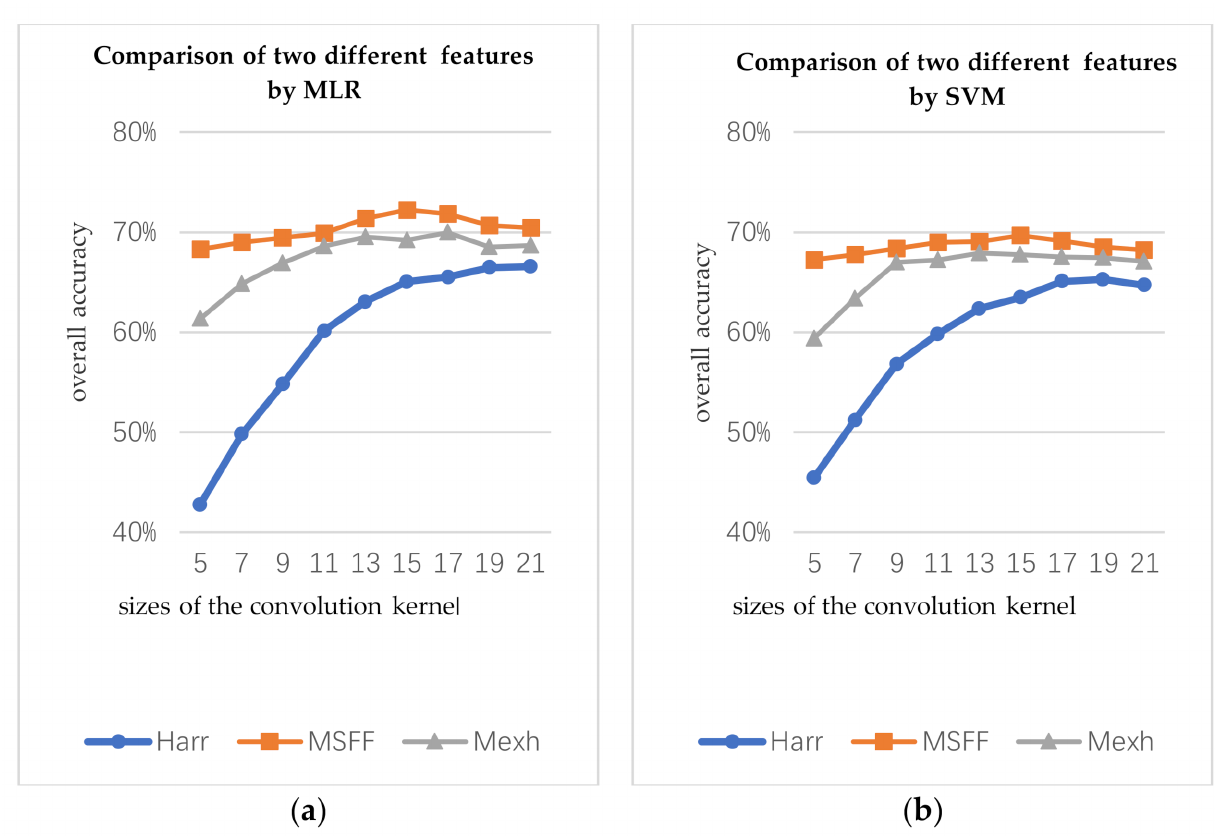
Figure 9. Classification accuracies for the different structure features of different scales on the Indian Pines data: ( a ) com- parison of classification results of three features in the MLR classifier and ( b ) comparison of classification results of three features in the SVM